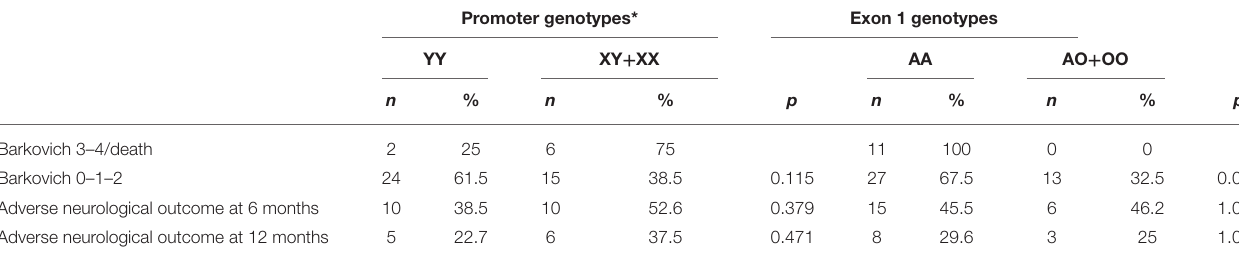
TABLE 2 | Association of brain MRI Barkovich score at 7–10 days or death, neurological outcome with Promoter and Exon1 genotypes. Promoter genotypes*